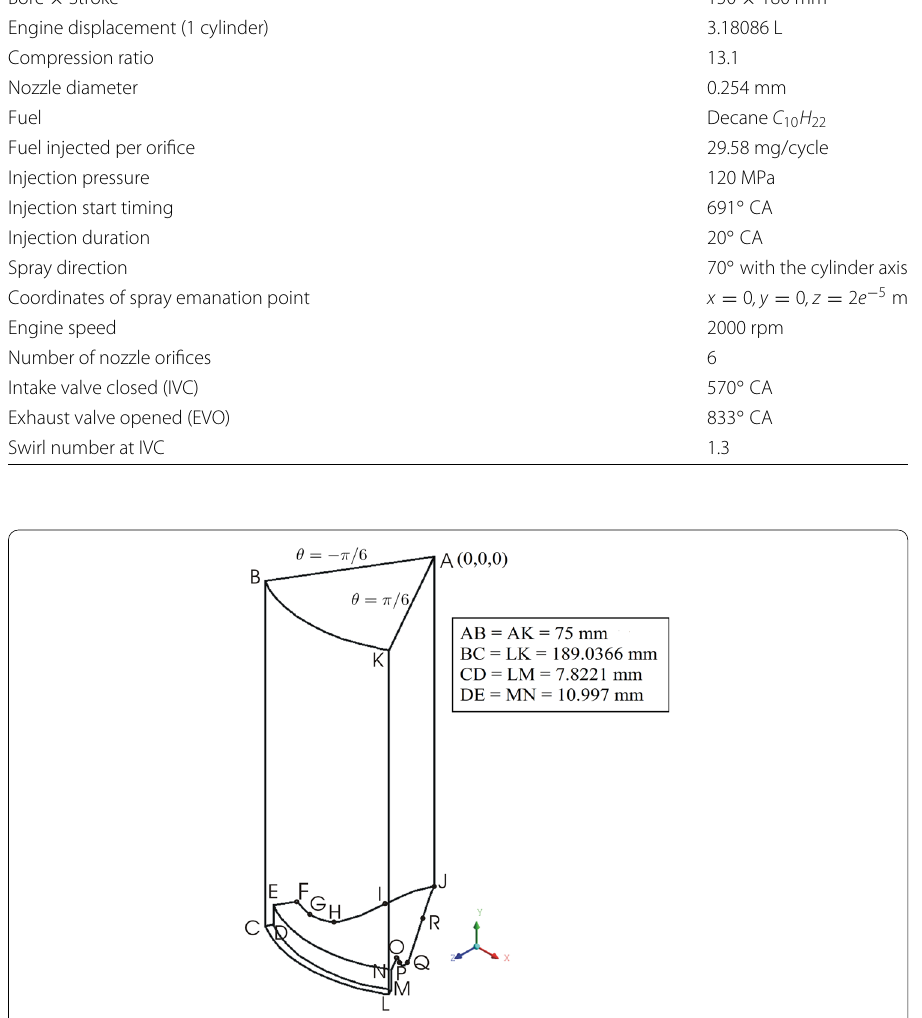
Fig. 1 Three-dimensional computational domain (a 3D sector of IC engine)